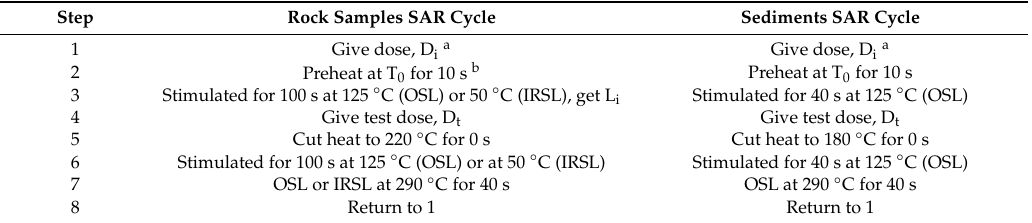
Table 1. Single Aliquot Regenerative dose protocol applied (L i and T i were calculated starting from the optically stimulated luminescence (OSL) curve, integrating the first 0.8 s minus a background estimated from the integral of the last 8 s).